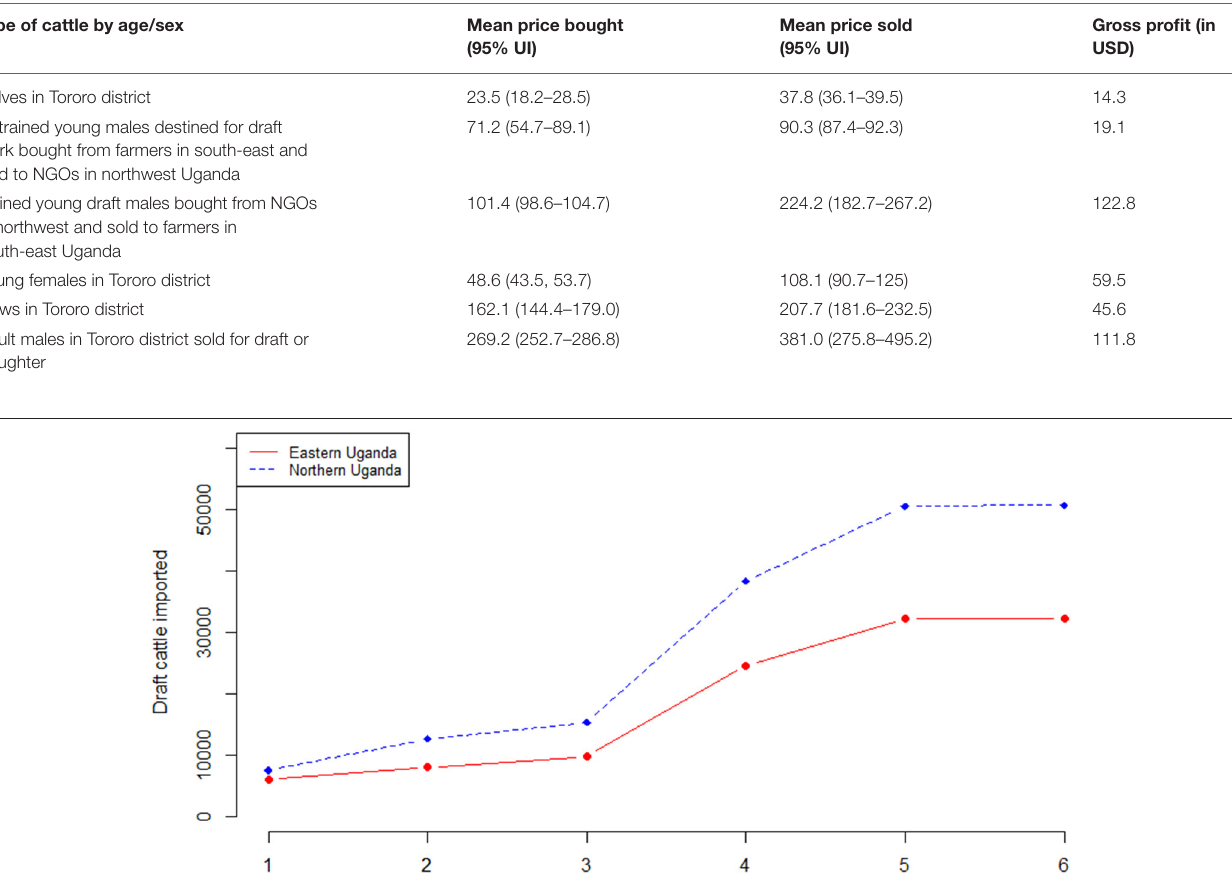
the cattle on foot or on trucks for months from one market to the other and back depending on the season. Long distance cattle as it increases the volume, distance, and frequency of inter- district trade. Additionally, walking of cattle from market may also expose them to tsetse infestation and thereby spread of rHAT within and between